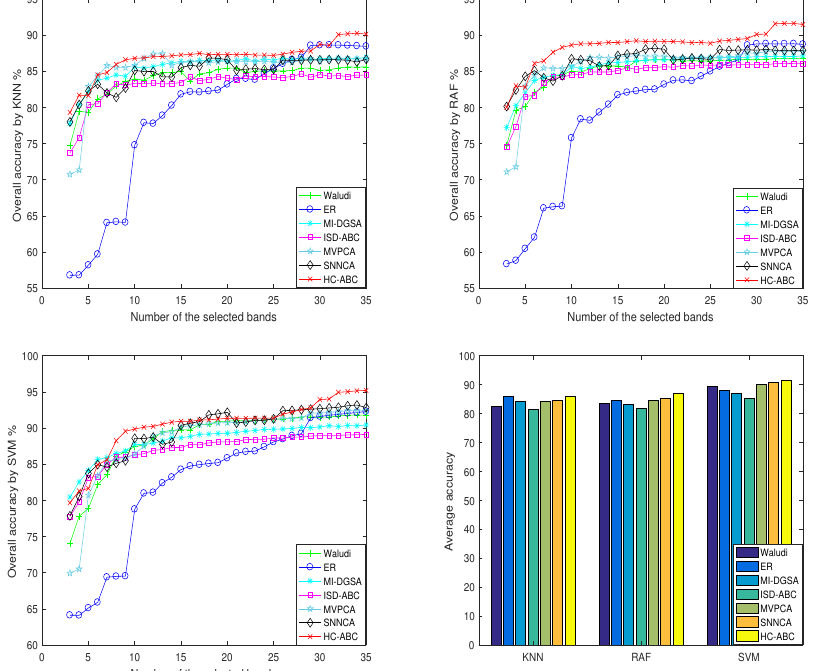
Figure 19. The results obtained by HC-ABC and the 6 comparison algorithms on Pavia University. For the Pavia University, it can be seen from Figure 19 that the OA values of HC-ABC show the same trend when the three classifiers are used, which is better than the six comparison algorithms in most cases. Specifically: (1) When using the KNN classifier, the OA value of HC-ABC is significantly better than that of the 6 comparison algorithms, except for part special number of bands. (2) For